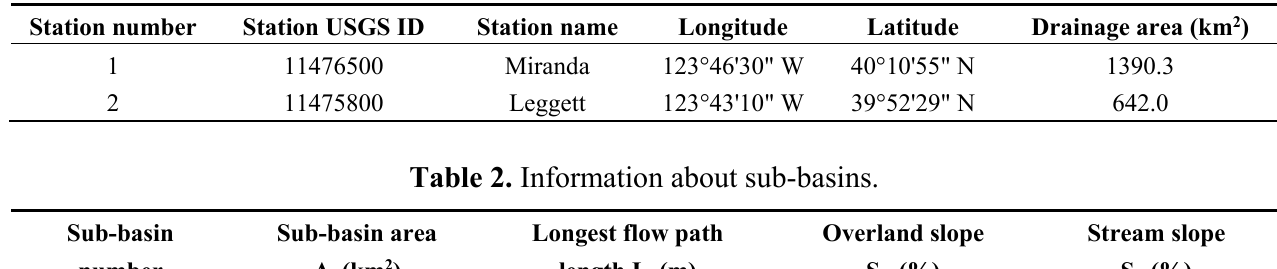
Table 1. Information about stream gauge stations.